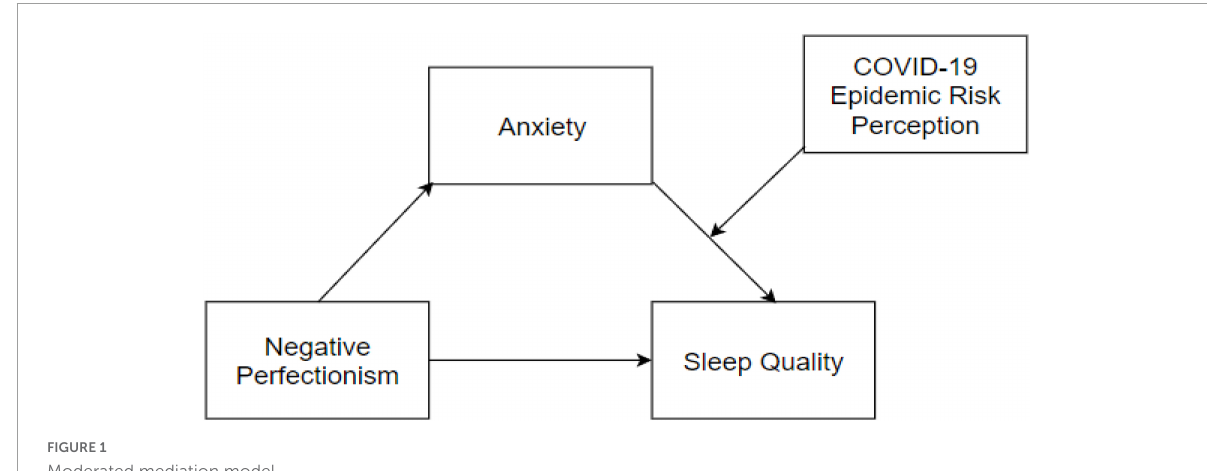
FIGURE1 Moderated mediation